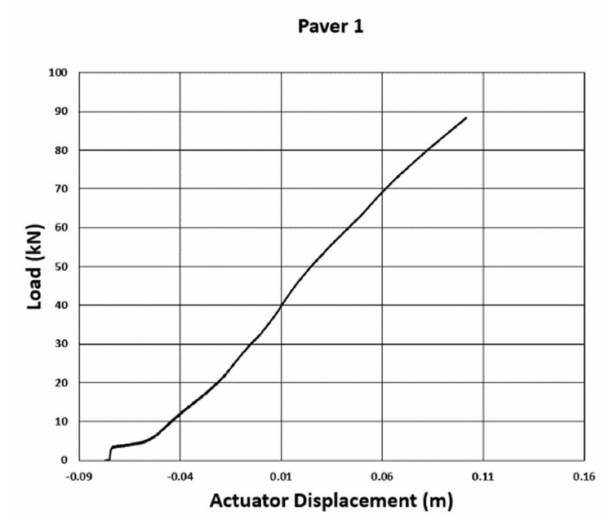
Figure 15. Load vs. actuator deflection Paver 1.